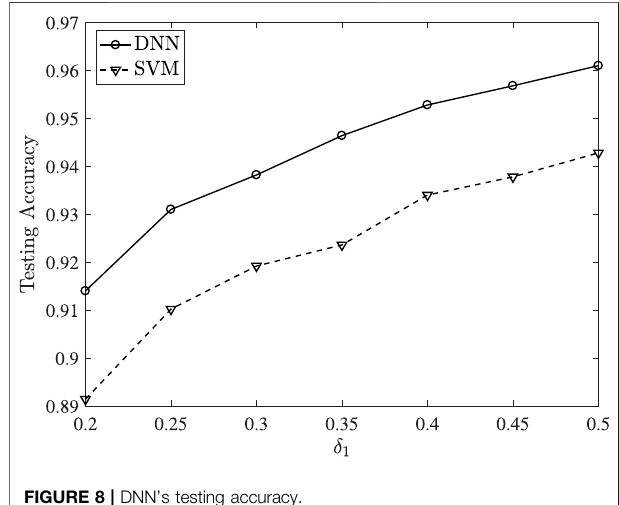
FIGURE 8 | DNN ’ s testing